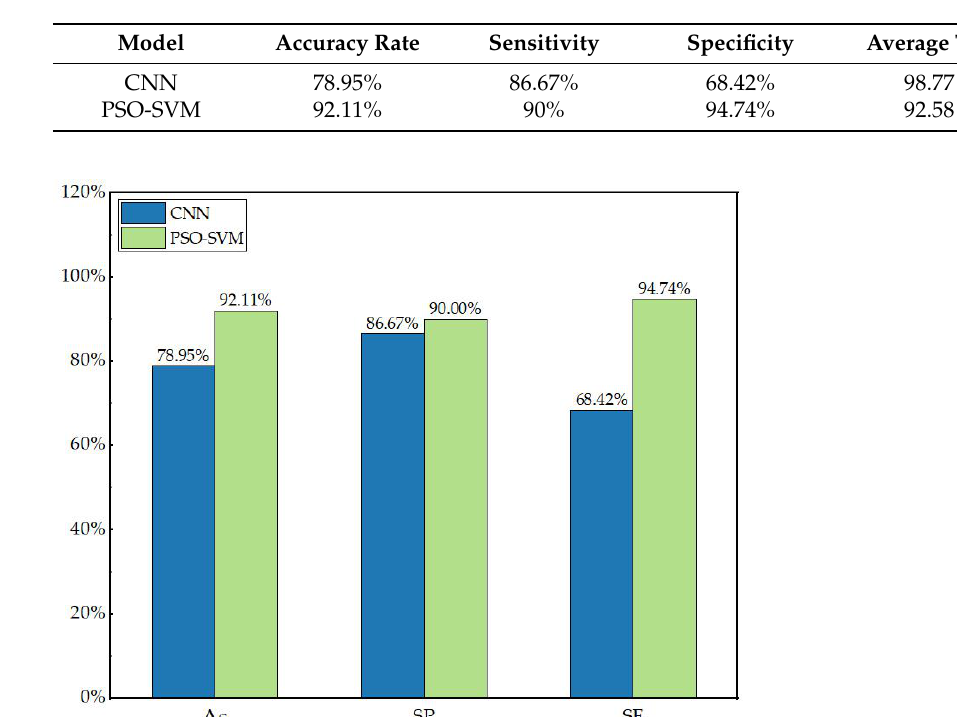
Figure 13. Image recognition classification results: ( a ) GWO-SVM; ( b ) PSO-SVM.